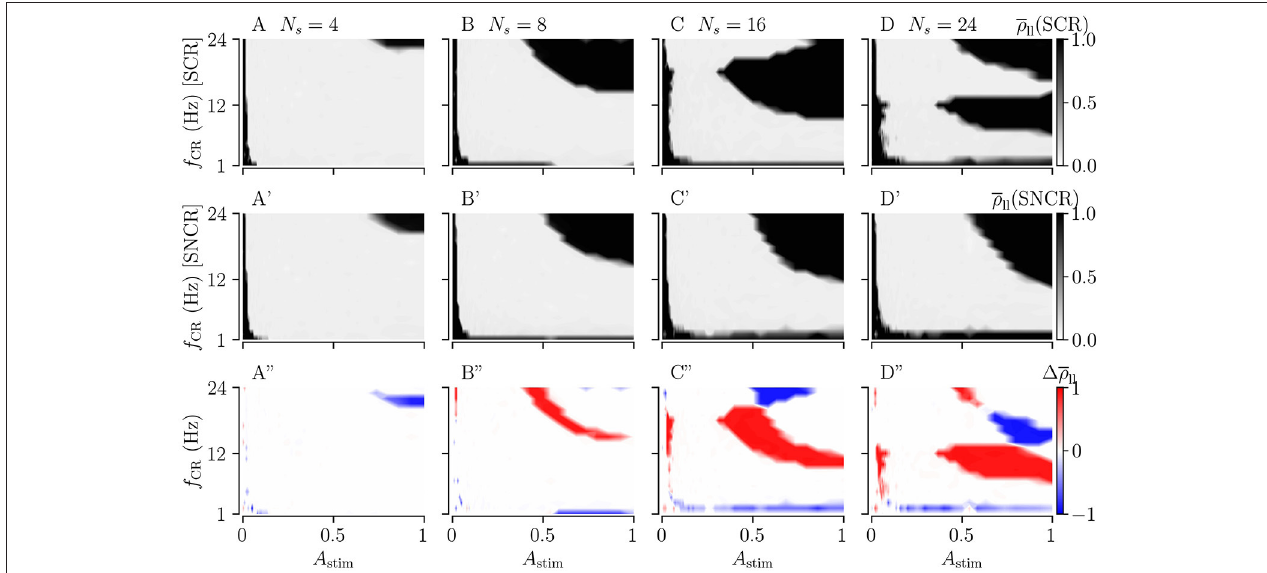
FIGURE 10 | Long-lasting effects of SCR and SNCR stimulation as a function of CR frequency, f CR , and simulation strength, A stim . Panels show the long-lasting Kuramoto order parameter for SCR (A–D) and for SNCR (A’–D’) . (A”–D”) show the difference between the long-lasting Kuramoto order parameter for SCR